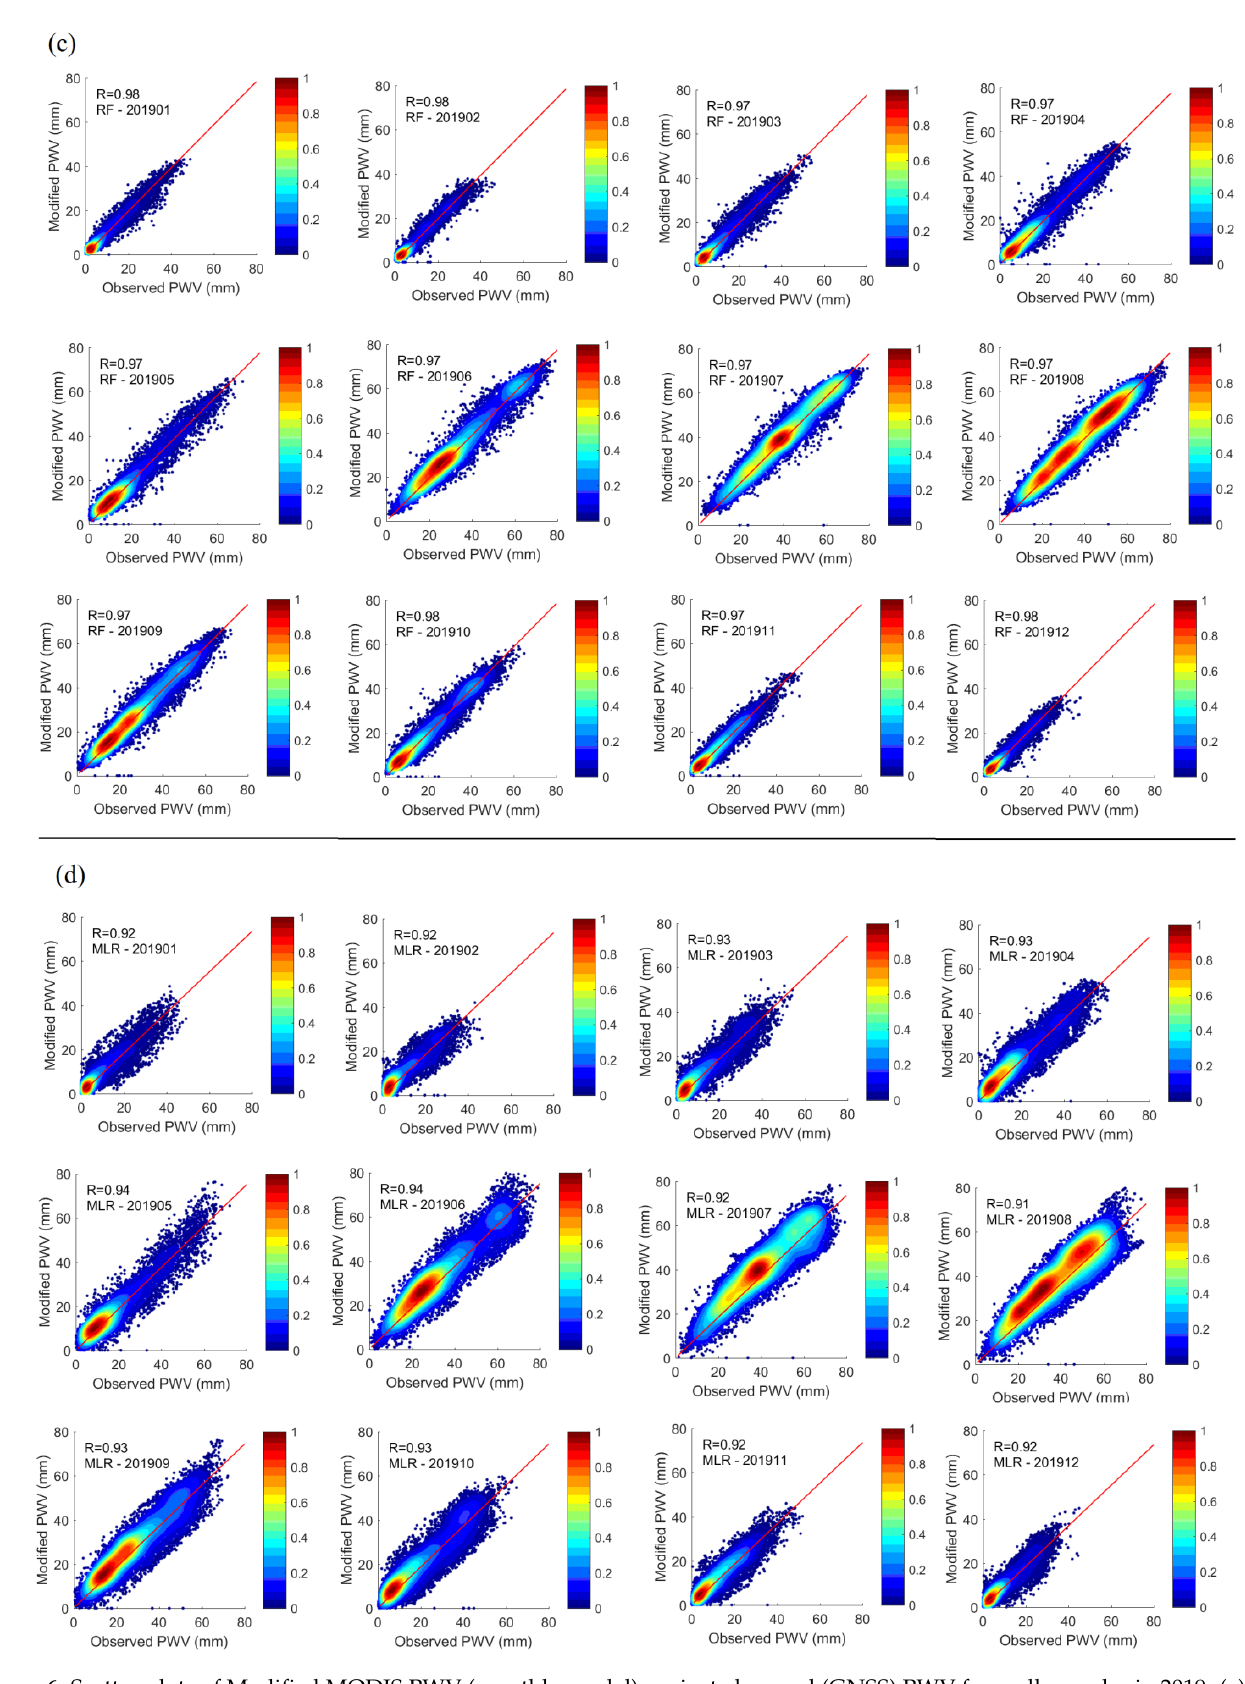
Figure 6. Scatter plots of Modified MODIS PWV (monthly model) against observed (GNSS) PWV from all samples in 2019. ( a ) the results of BPNN, ( b ) the results of GRNN, ( c ) the results of RF, ( d ) the results of